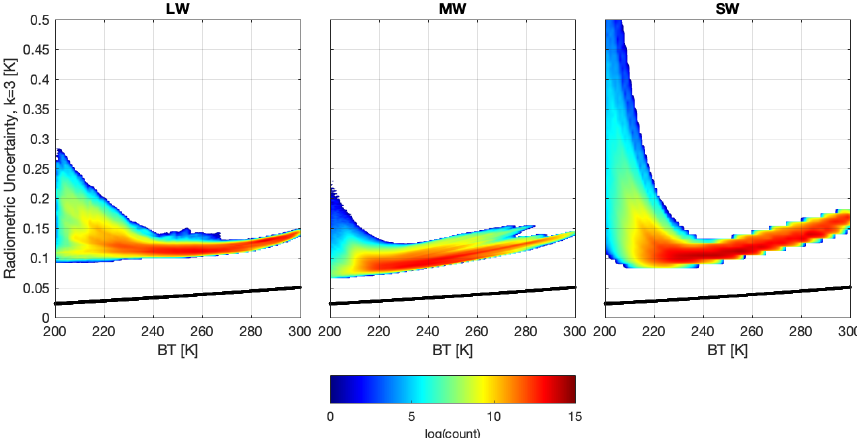
Figure 1. Radiometric uncertainty (RU) of the three spectral bands of the SNPP Cross-track Infrared Sounder (CrIS) operational sounder compared to that for ARI. The format of this figure follows that of Tobin et al. [18]. The RU is assessed via perturbation of the calibration equation, following accepted metrology approaches, as described in Section 4.2 and by Tobin et al. [18]. The colors represent the density of occurrence in a typical Earth atmosphere for the CrIS RU. The lower bound for CrIS is set by uncertainty in the radiance of its internal calibration target (ICT). Larger longwave (LW) band (shortwave (SW) band) uncertainties arise from residual non-linearity (polarization) correction uncertainty, while the midwave (MW) band values are a combination of both mechanisms. The ARI calibration uncertainty, shown in black, is totally dominated by the uncertainty of the radiance from its internal calibration target resulting in an order of magnitude reduction in peak uncertainties at cold temperatures. Additionally, the ARI On-orbit Absolute Radiance Standard (OARS, see Section 5) provides end-to-end calibration verification with direct on-orbit traceability to absolute standards.